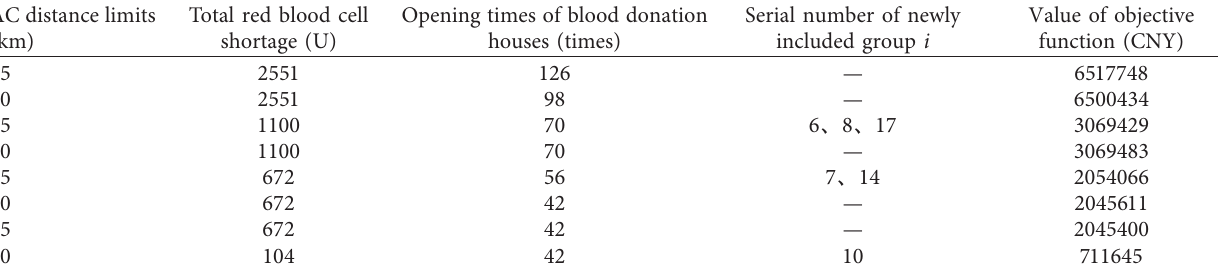
Figure 5: Results of different donation time limits. Table 11: Impact of AC distance change on red blood cell